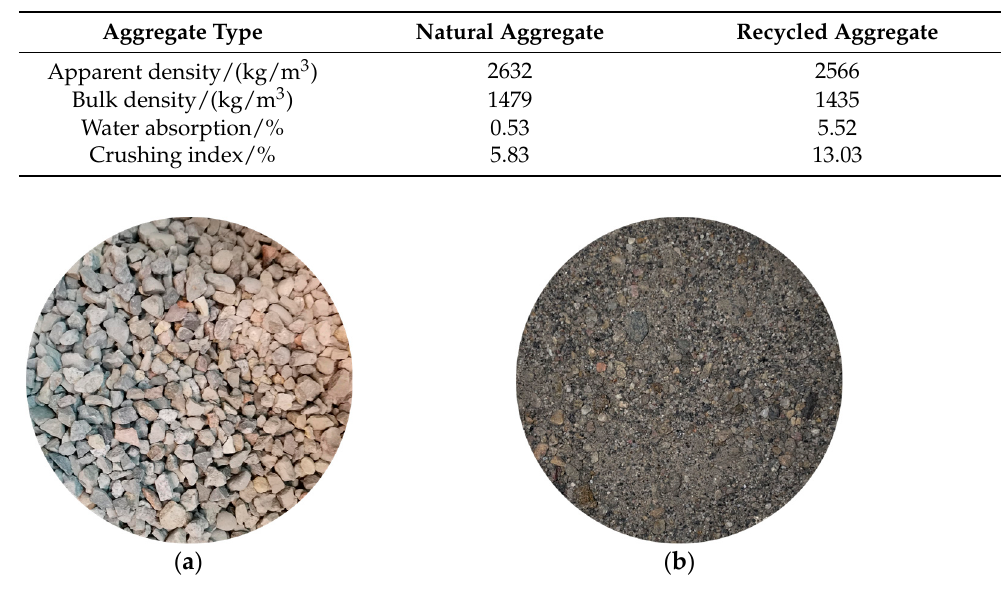
Figure 3. Particle size distribution of fly ash. Table 1. Performance parameters of coarse aggregate.